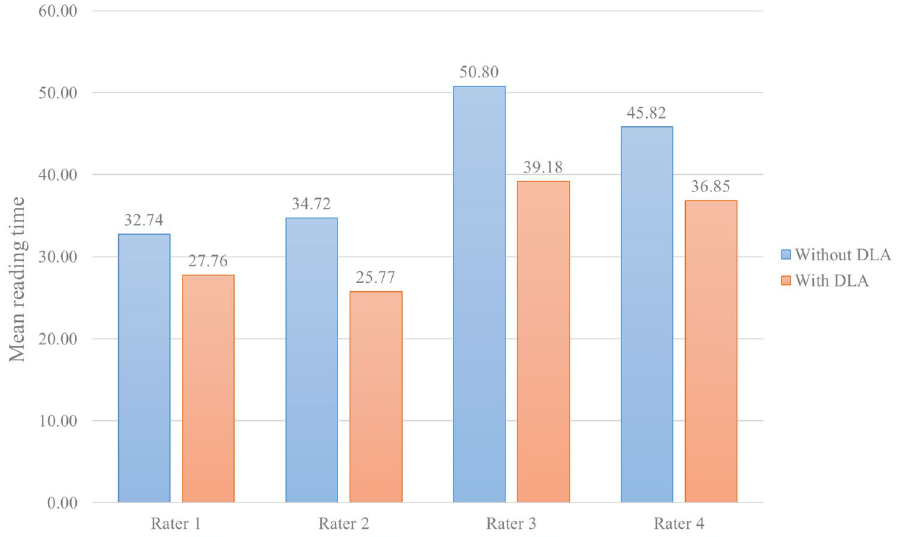
Figure 3. Comparison of the reading time for 20 individuals by four different raters with or without deep learning algorithm as computer-aided detection system. The bar graph represents the average of reading time [s] without and with deep learning